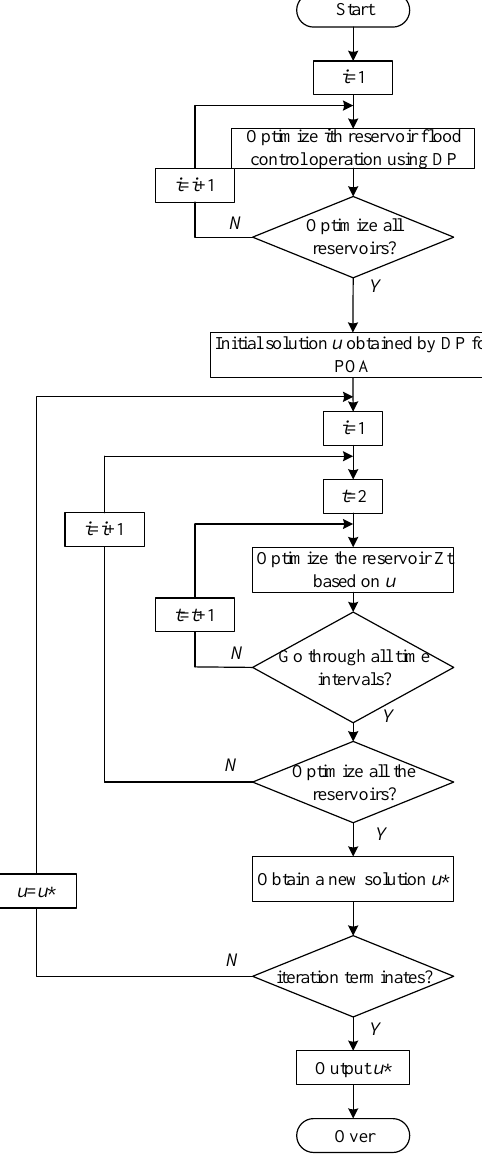
Figure 2. The procedure of Dynamic Programming-Progressive Optimality Algorithm (DP-POA).